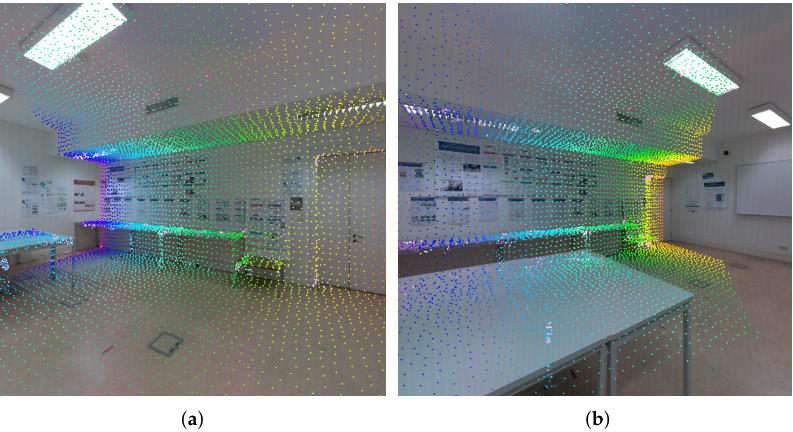
Figure 2. Pairwise mappings between images ( a , b ). The projections of the vertices are colored to identify the pairwise mappings between images. For example, in both images, the projections in orange represent the entrance door of the